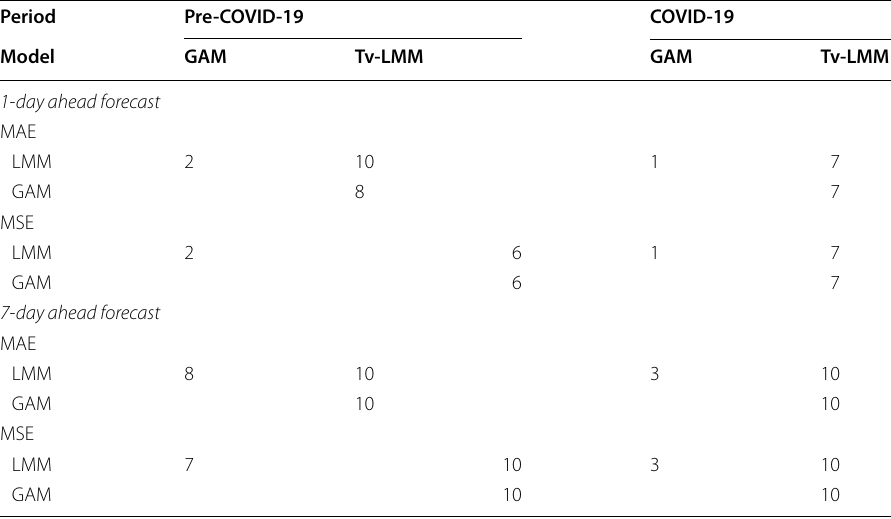
Table 7 The numbers of cryptocurrencies that reject the null hypothesis in terms of the MAE and MSE criteria out-of-sample procedure during the pre-COVID-19 and COVID-19 periods